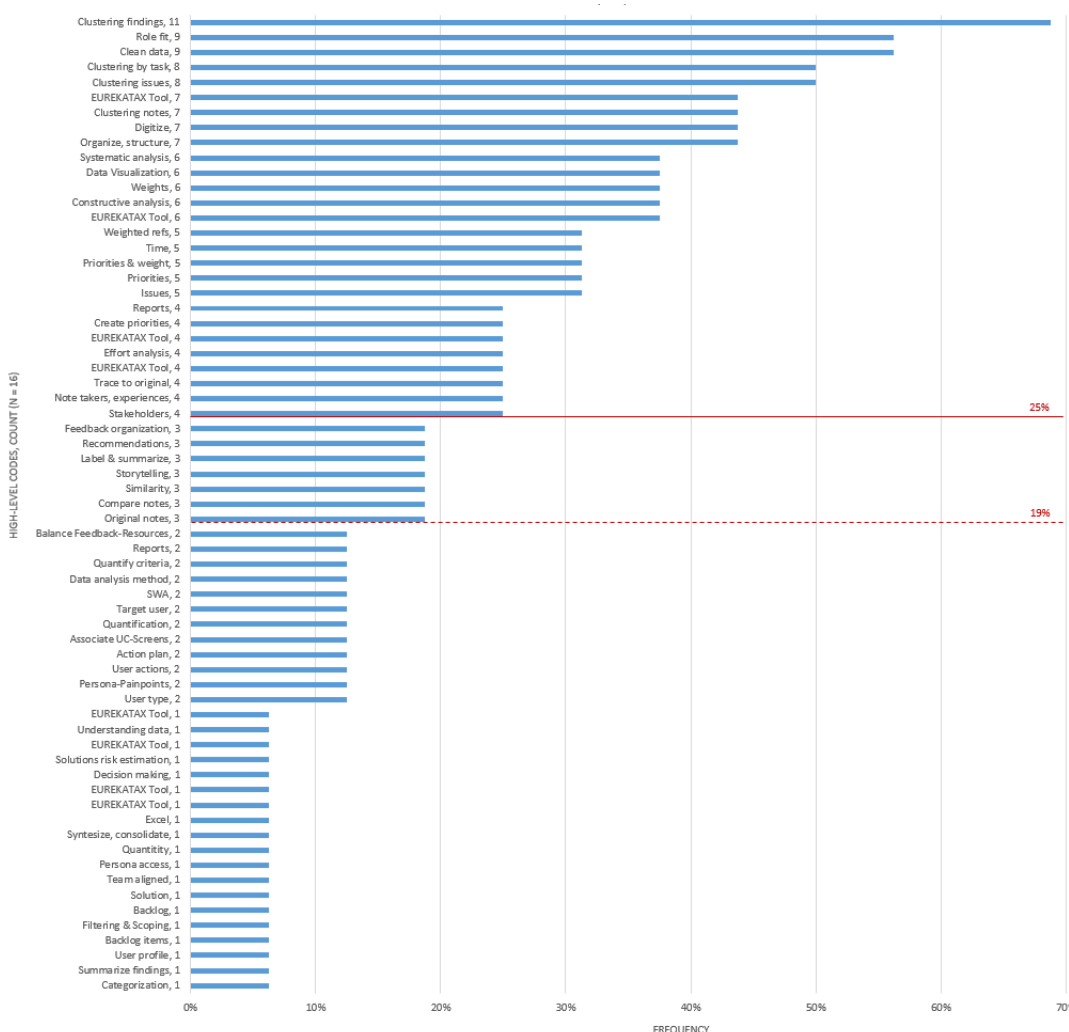
Figure 12. Distribution of codes frequencies across the participating teams (N =